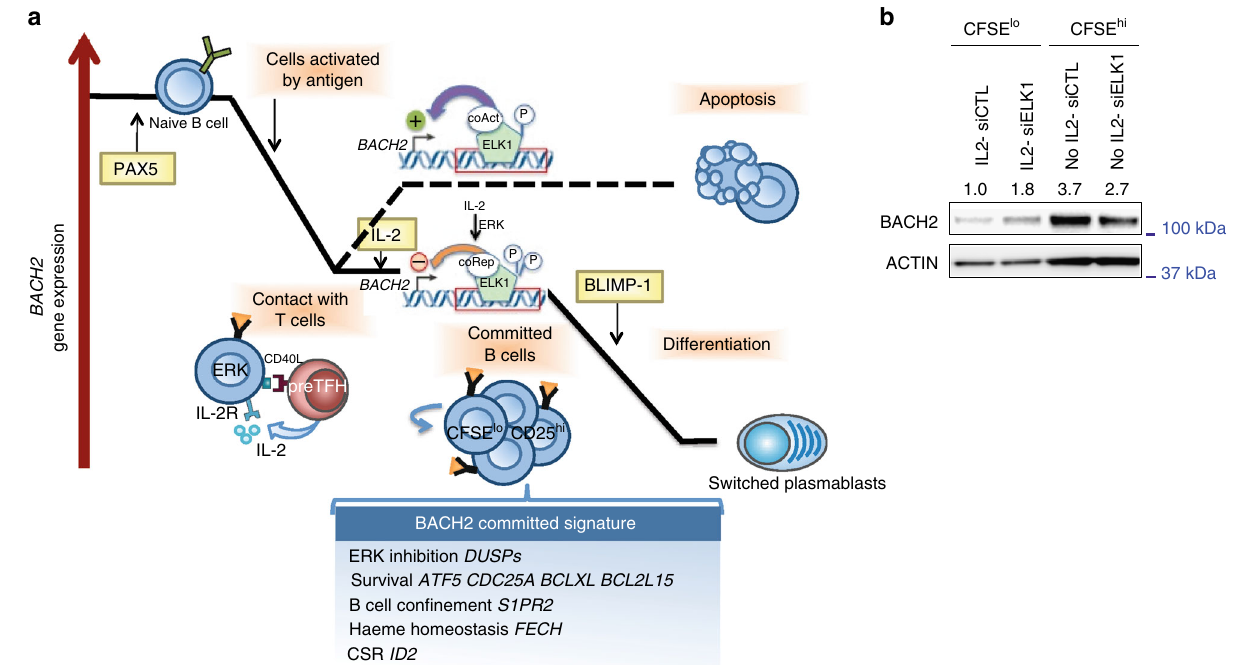
Fig. 10 Proposed model of BACH2 regulation during terminal B cell differentiation. a BACH2 is highly expressed in naive B cells, under PAX5 control. Its expression decreases with antigen priming. In absence of T cell help, BACH2 acts as a key lock in repressing the plasma cell transcriptional program. BACH2 expression is under the control of the transcriptional activity of an enhancer mediated by ELK-1 in association with co-activator (coAct) complex. Contact with cognate helper T cells and signals that sustained ERK signalling instruct a dynamic switch in ELK1 transcriptional activity that may recruit a corepressor (coRep) complex responsible for BACH2 downregulation and plasma cell fate commitment. The IL-2-primed activated B cells that have proliferated (CFSE lo CD25 hi ) are committed for plasma cell differentiation. The differentiation program initiated by IL-2 revealed the major contribution of BACH2 downregulation. RNA-seq and ChIP-seq revealed the broad program of molecular and cellular processes regulated by BACH2 at this early time point of B cell fate commitment. b BACH2 expression levels analysed by immunoblotting in subpopulations of D4-activated B cells sorted based on CFSE dilution. Naive B cells were primed or not with IL-2 and electroporated with siELK1 or a control siRNA (siCTL). β -ACTIN was used as loading control. Values are the average fold changes in the expression levels of BACH2 normalised to β -ACTIN levels for three independent